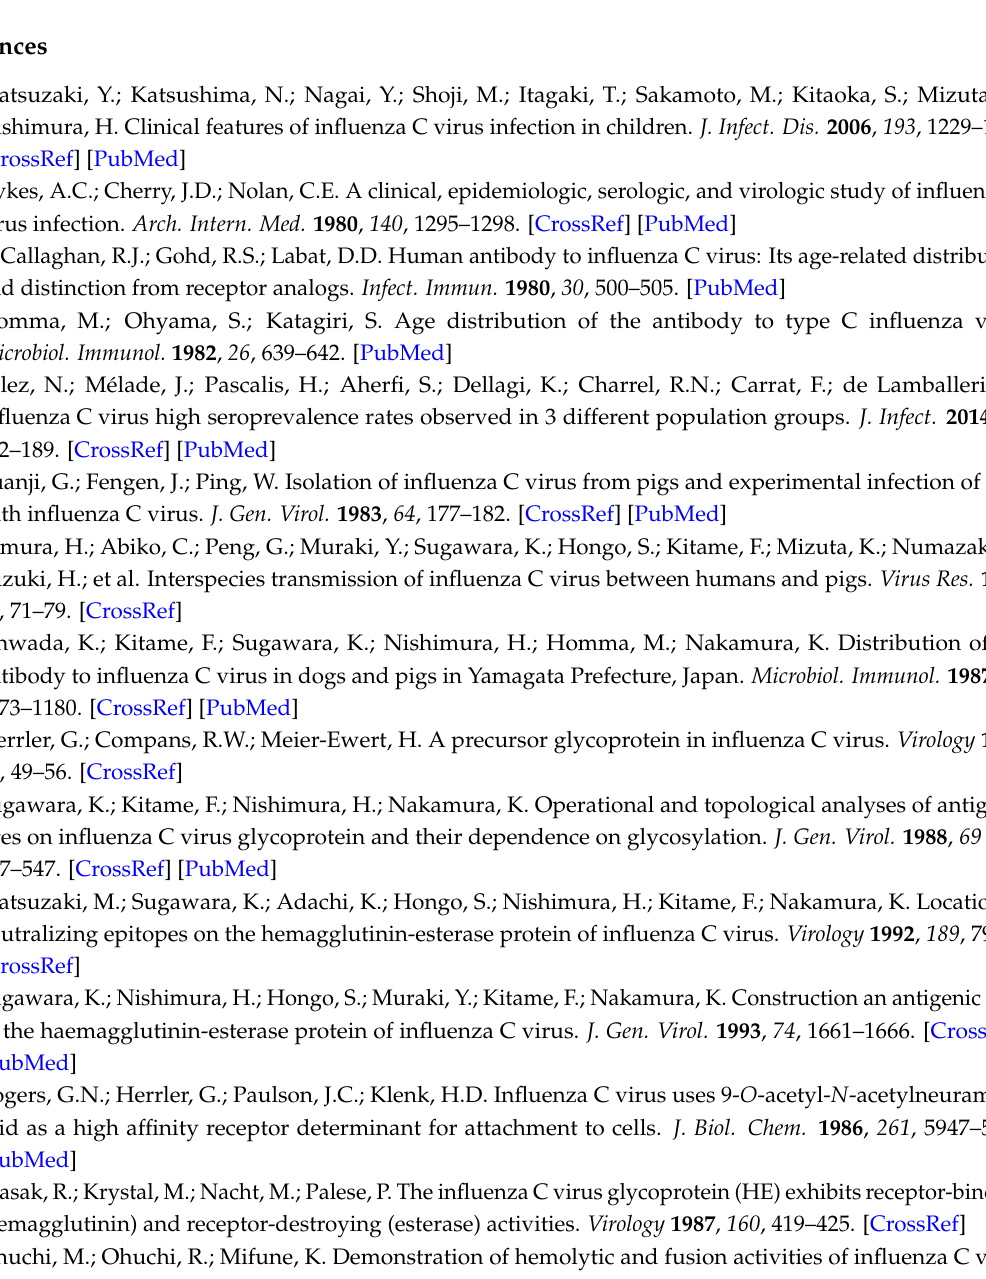
Table S1: number of sequences and isolation year by country, Table S2: selection pressure (dN-dS) of antigenic sites, Figure S1: number of N -glycosylation sequons in the HE1 region, Data S1: sequence data of influenza C viruses used in this study, Data S2: sequence data of influenza A/H3N2 viruses used in this study, Data S3: sequence data of influenza A/H1N1 viruses used in this study, Data S4: sequence data of influenza B viruses used in this